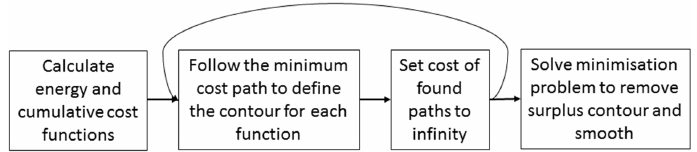
Figure 2. Flow chart of the segmentation process. The energy functional and cumulative cost functions are calculated to determine the minimal cost paths. Once all paths are found, the minimisation problem given in Equation (1) is solved to remove one contour, resulting in the set of